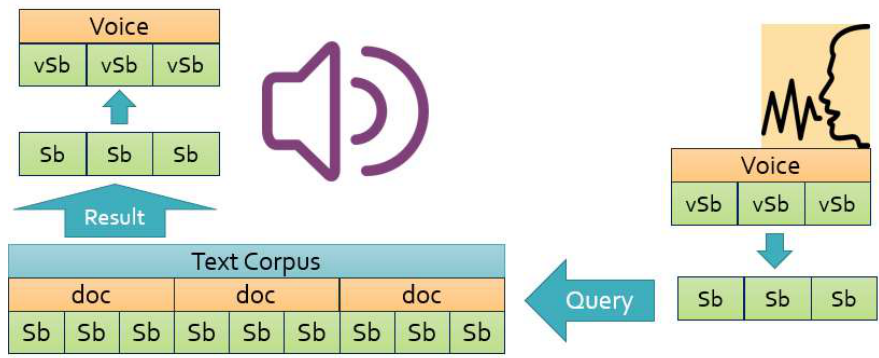
Figure 3. Principle of speech retrieval based on syllable-coded document corpus.